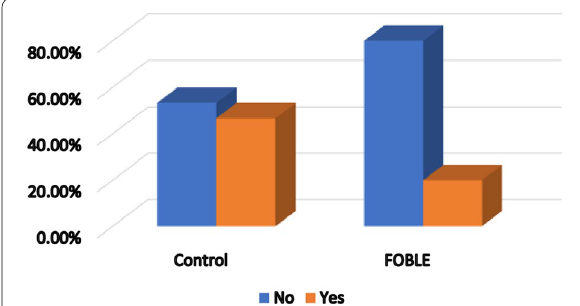
Fig. 3 Failed conventional care and shift to ICU between the two